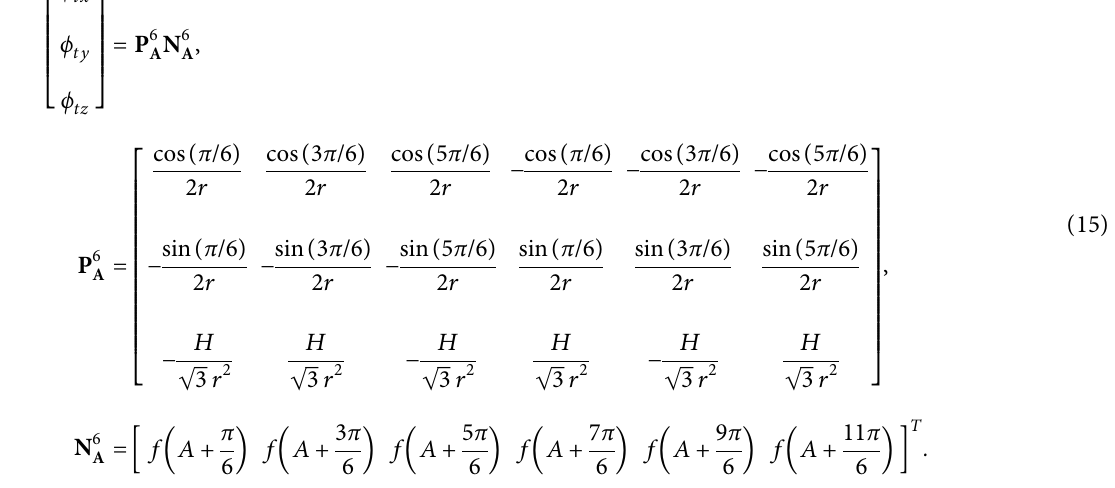
Figure 6. The positions of the eight support points in the OXYZ coordinate can be determined as ( A + ( π /8 )) , ( A + ( 3 π /8 )) , ( A + ( 5 π /8 )) , ( A + ( 7 π /8 )) , ( A + ( 9 π /8 )) , ( A + ( 11 π /8 )) , ( A + ( 13 π /8 )) , and ( A + ( 15 π /8 )) , and the track profile amplitude in these positions can be represented as f ( A + ( π /8 )) , f ( A + ( 3 π /8 )) , f ( A + ( 5 π /8 )) , f ( A + ( 7 π /8 )) , f ( A + ( 9 π /8 )) , f ( A + ( 11 π /8 )) , f ( A + ( 13 π /8 )) , and f ( A + ( 15 π /8 )) accordingly. Similar to the analysis in a six- support-points design, the height difference between sup- port point i ( i � 1, 2, 3, 4) and support point i + 4 can result in the deviation from the ideal X axis and Y axis, respectively, and they can be calculated